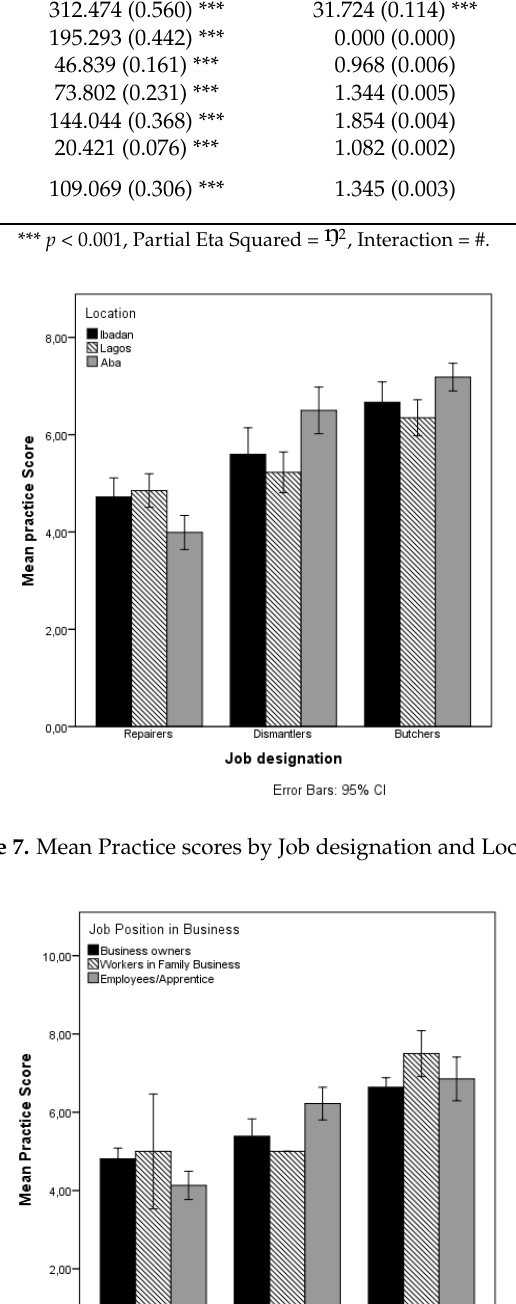
Table 5. F -values of the Two-Way ANOVA for the practice score.